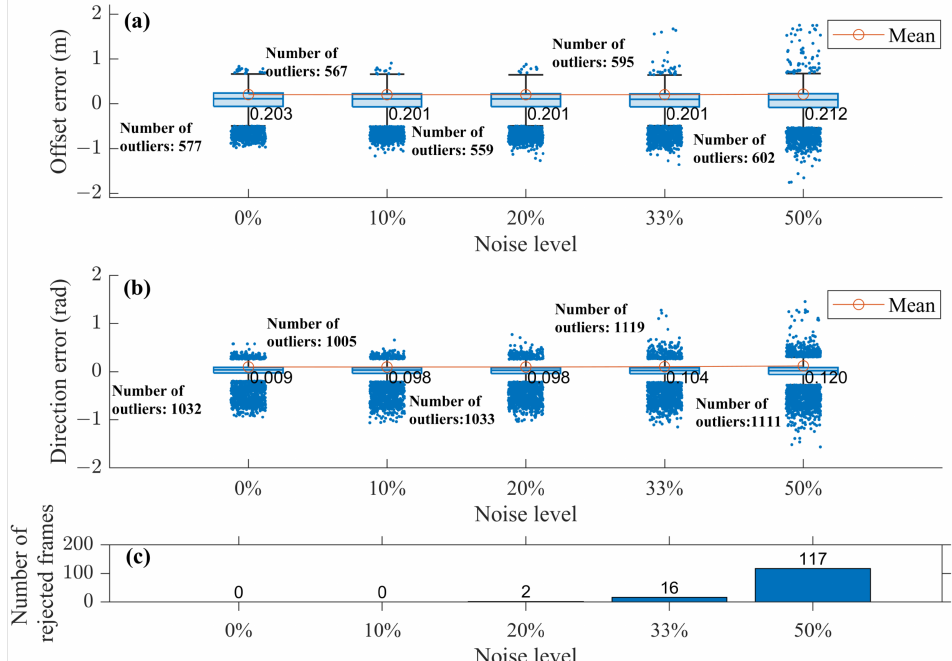
Figure 12. Result from dataset 1 with different levels of added noise: ( a ) offset error; ( b ) direction error; ( c ) number of rejected